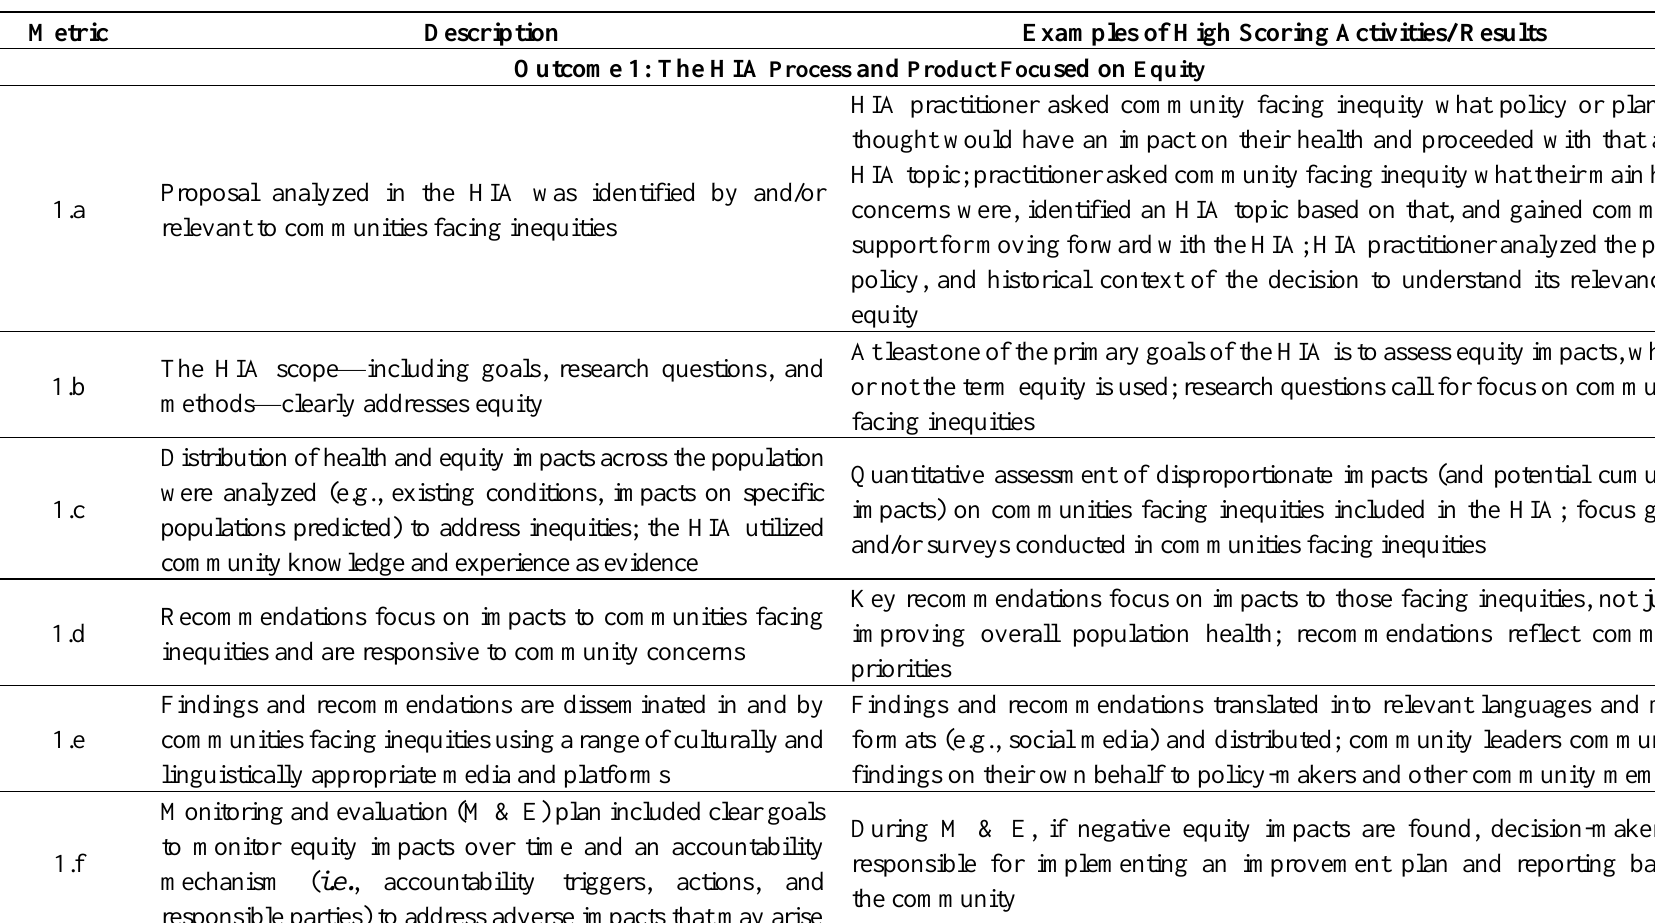
Table 1. Equity Metrics for Health Impact Assessment